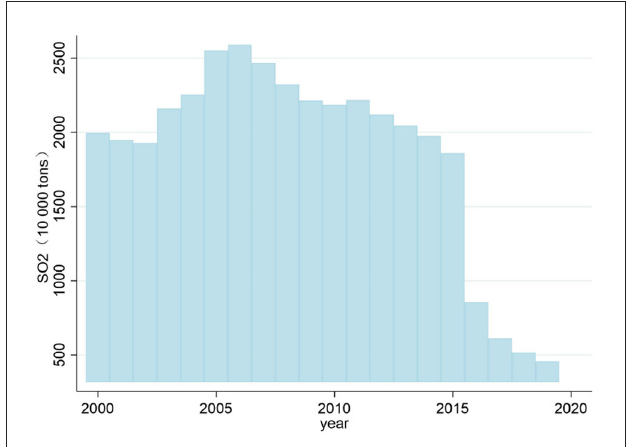
FIGURE3 National sulfur dioxide intensity changes from 2000 to